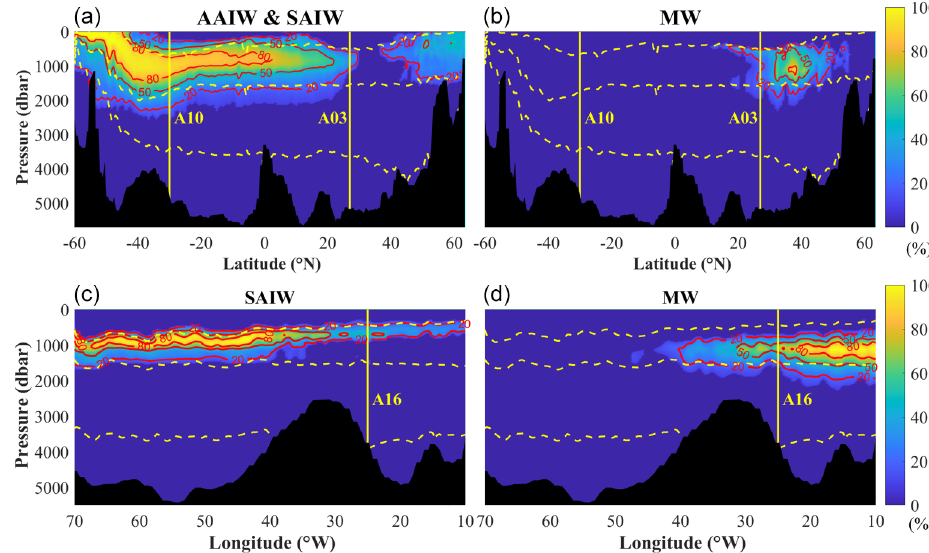
Figure 11. Distribution of water masses in the intermediate layer based on A16 (a, b) and A03 (c, d) sections. Contour lines show fractions of 20%, 50% and 80%, yellow vertical lines show cross overs with other sections, and dashed yellow lines show the vertical boundaries of layers (neutral density at 27.10, 27.90 and 28.10kgm − 3 ).